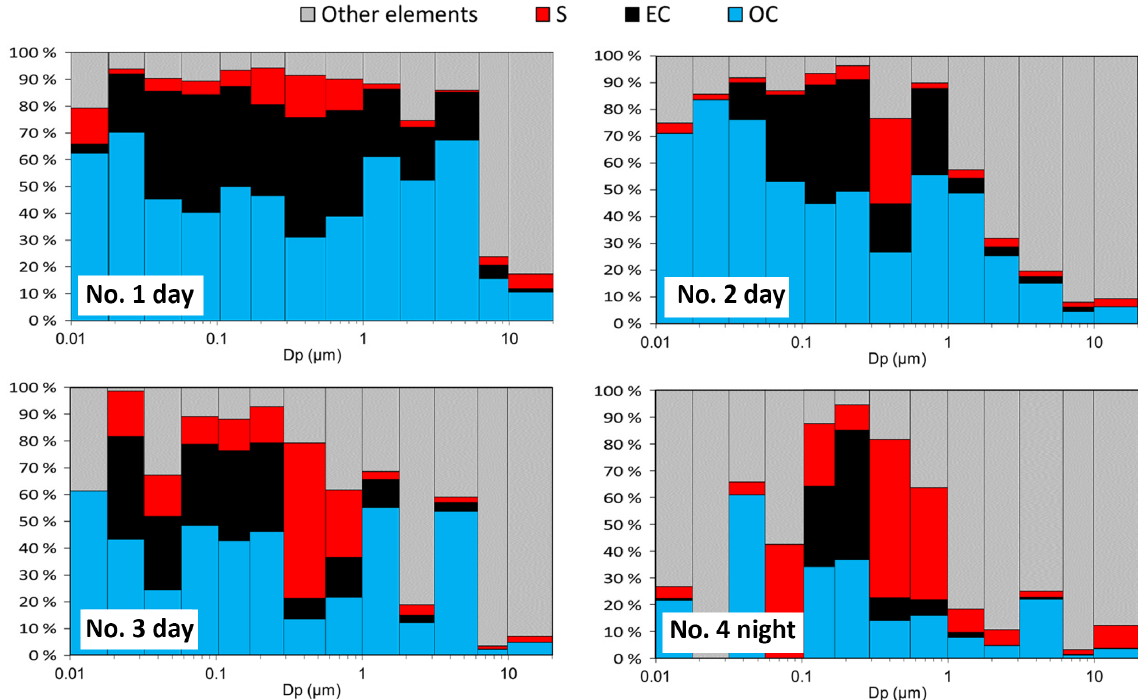
Figure 5. Proportions of OC, EC, sulfur, and other elements by particle